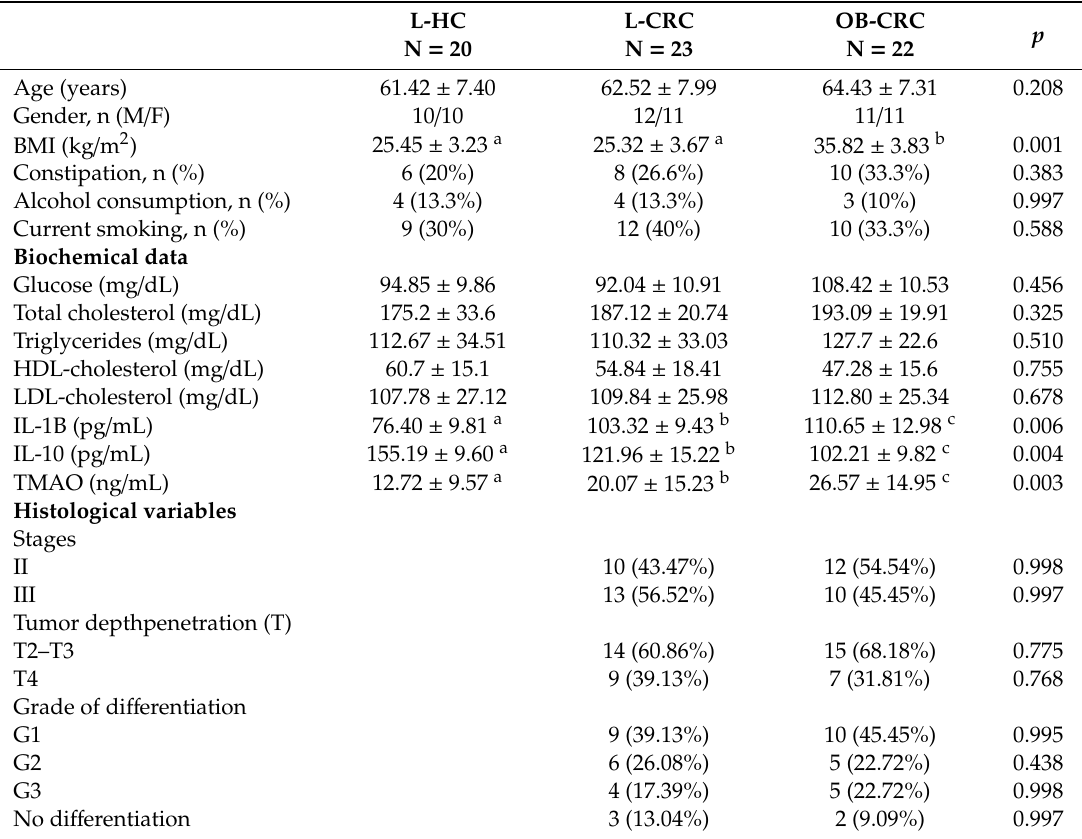
Table 1. Clinical and biochemical characteristics, serum levels of trimethylamine N-oxide (TMAO) and inflammatory markers in the study